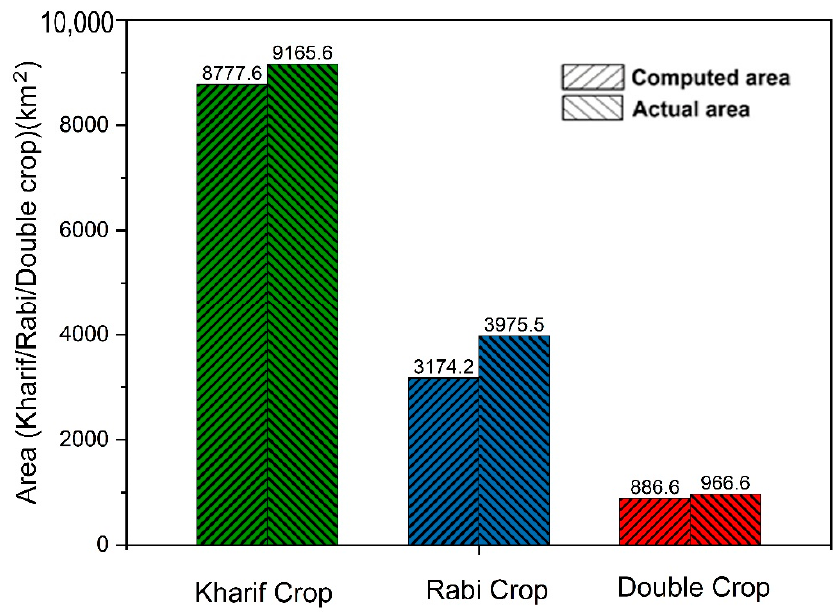
Figure 10. The area under Kharif, Rabi, and double crop (computed and actual area).